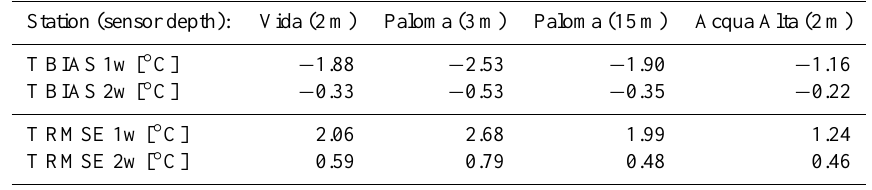
Table 2. Biases and root mean square errors (RMSE) [ ◦ C] between modeled POM1w, POM2w ocean temperatures and in situ observations at Vida, Paloma and Acqua Alta observational platforms during February 2012.